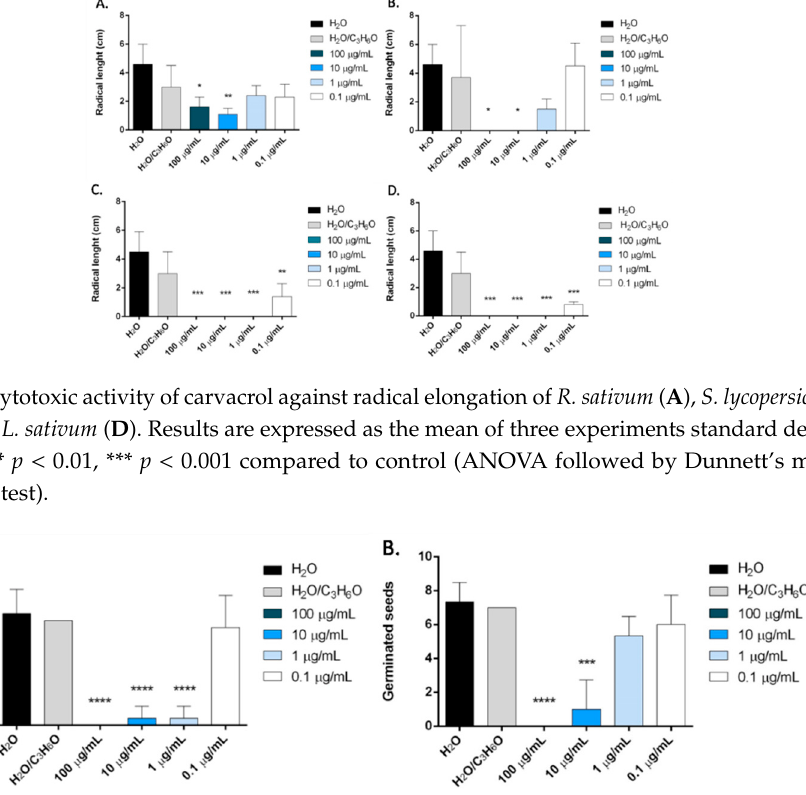
Figure 10. Phytotoxic activity of carvacrol against germination of L. sativa ( A ) and S. lycopersicum ( B ). Results are expressed as the mean of three experiments standard deviation. *** p < 0.001, **** p < 0.0001 compared to control (ANOVA followed by Dunnett’s multiple comparison test).